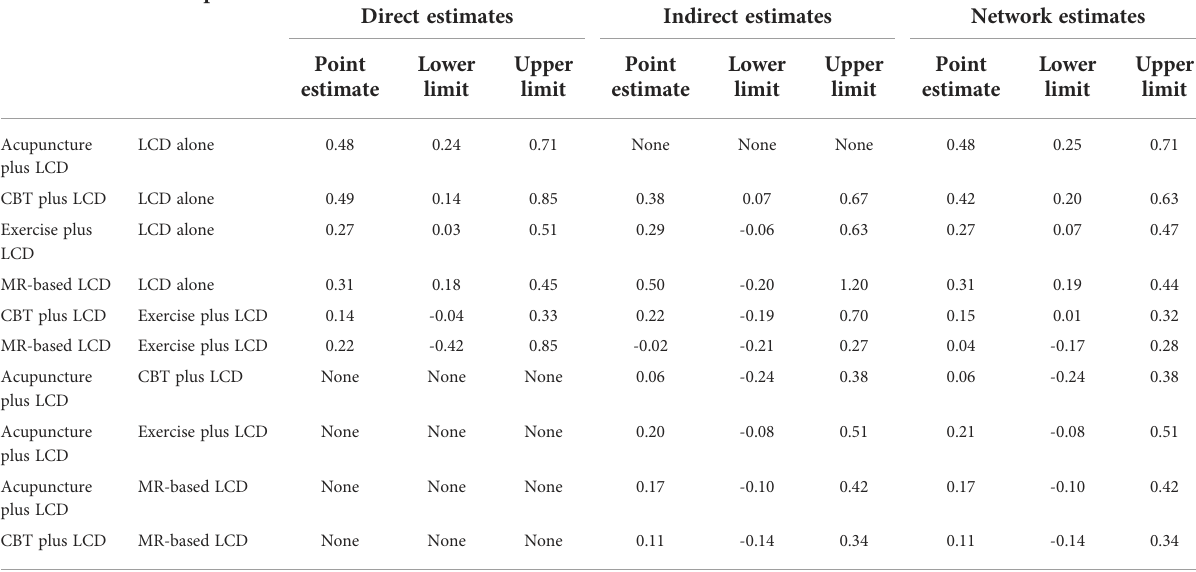
TABLE 2 Results of direct, indirect comparison and network meta-analysis.